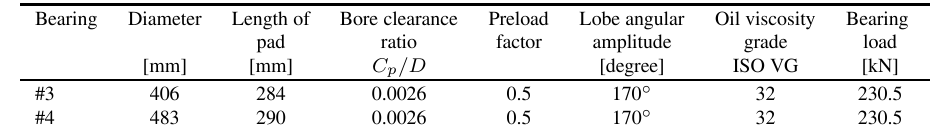
Table 2 Geometrical characteristics of elliptical journal bearings #3 and #4